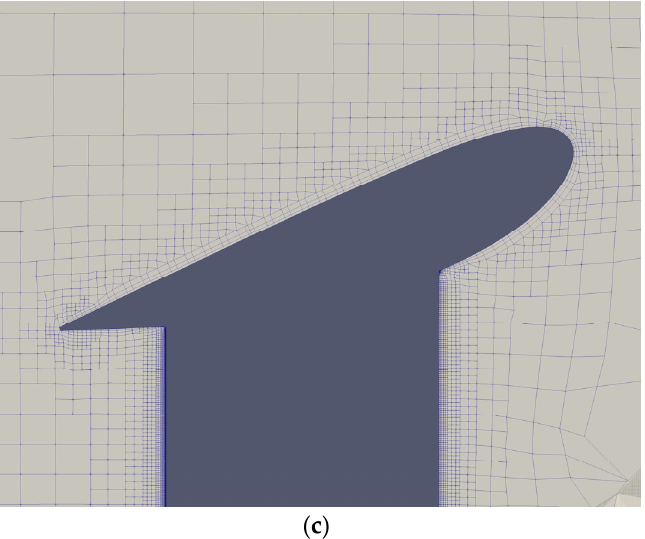
Figure 7. Grid details around the original duct and struct (medium grid): ( a ) angle view; ( b ) side view; and ( c ) junction between duct and struct.